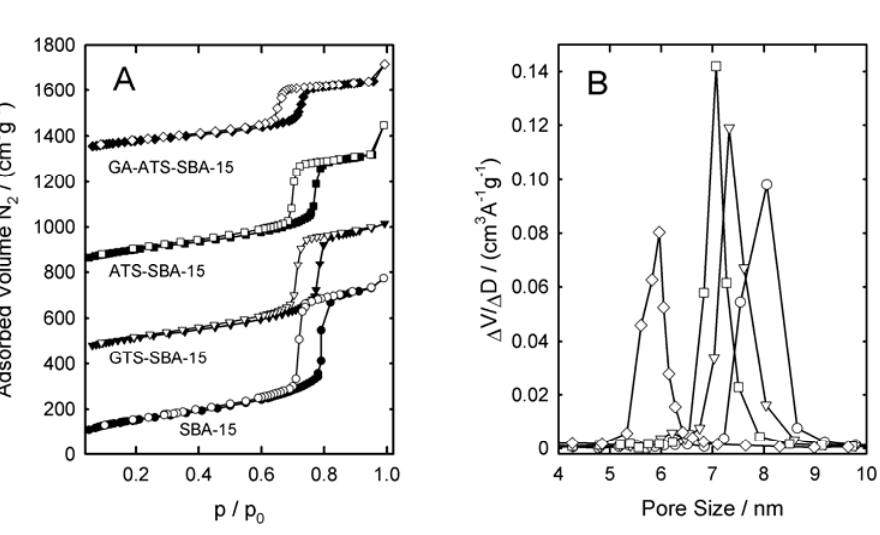
Figure 2. Nitrogen sorption isotherms at 77 K of SBA-15(circle), GTS-SBA-15(triangle), ATS-SBA-15(square) and GA-ATS-SBA-15(rhombus). Isotherms are shifted by 500 cm 3 g − 1 for clarity. Closed symbols: adsorption branch, open symbols: desorption branch. B: BJH Pore size distribution of the samples calculated from the desorption branch of the